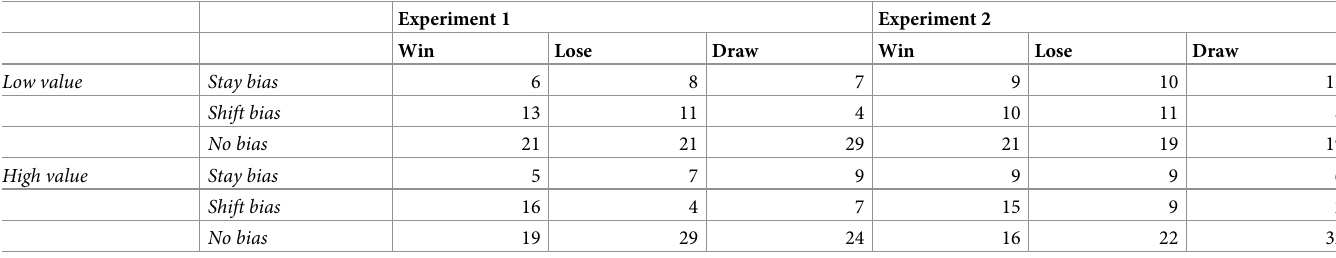
Table 3. Numbers of participants with specific biases or no biases in the unexploitable blocks of Experiments 1 (N = 40) and 2 (N =